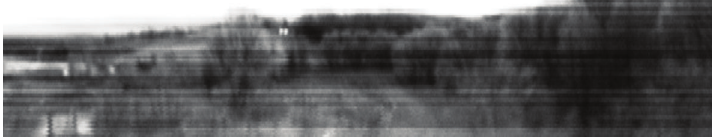
Figure 13: Starting image.